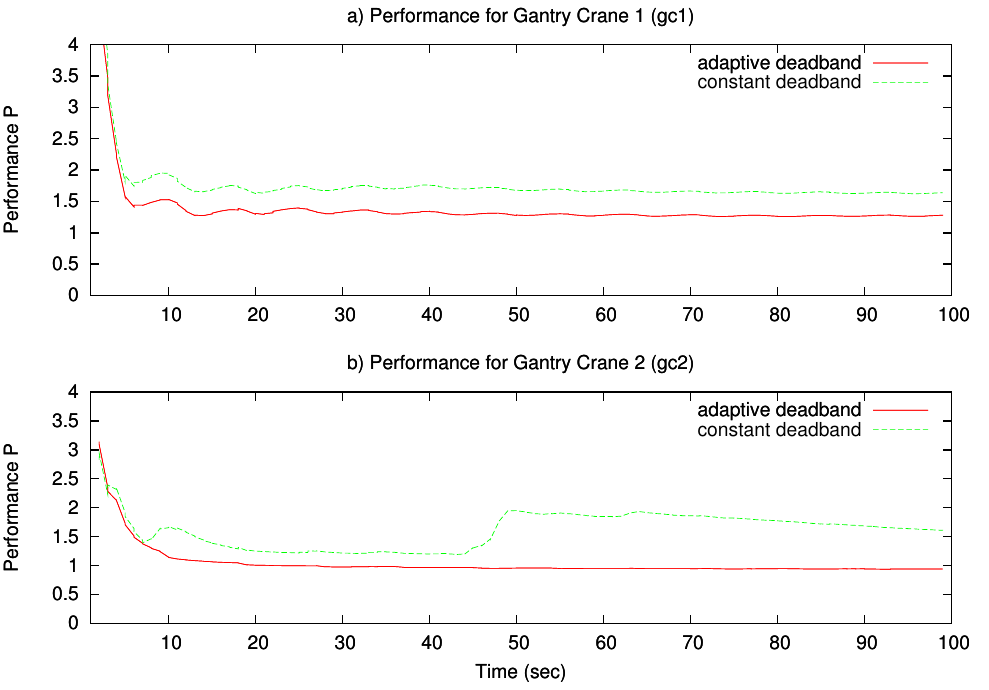
Figure 13. Performance comparison between optimal constant deadband and network adaptive deadband in the